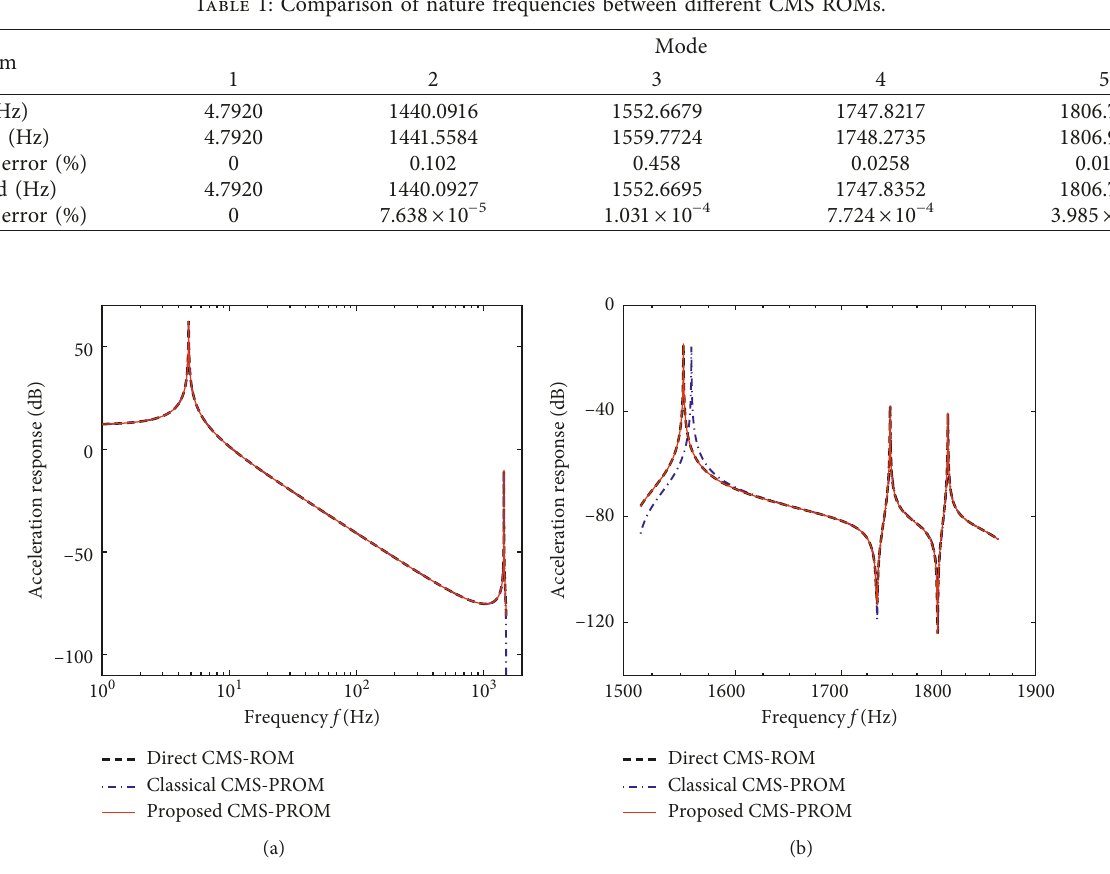
Figure 7: Comparison of harmonic responses between different CMS ROMs. (a) Frequency range: 0–1500Hz. (b) Frequency range: